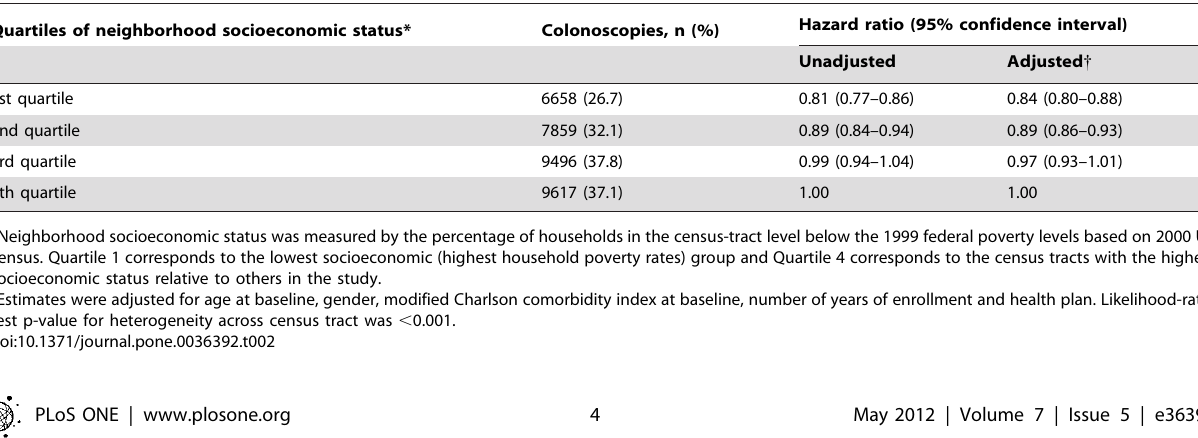
Table 2. Association between neighborhood socioeconomic status and use of any colonoscopy,